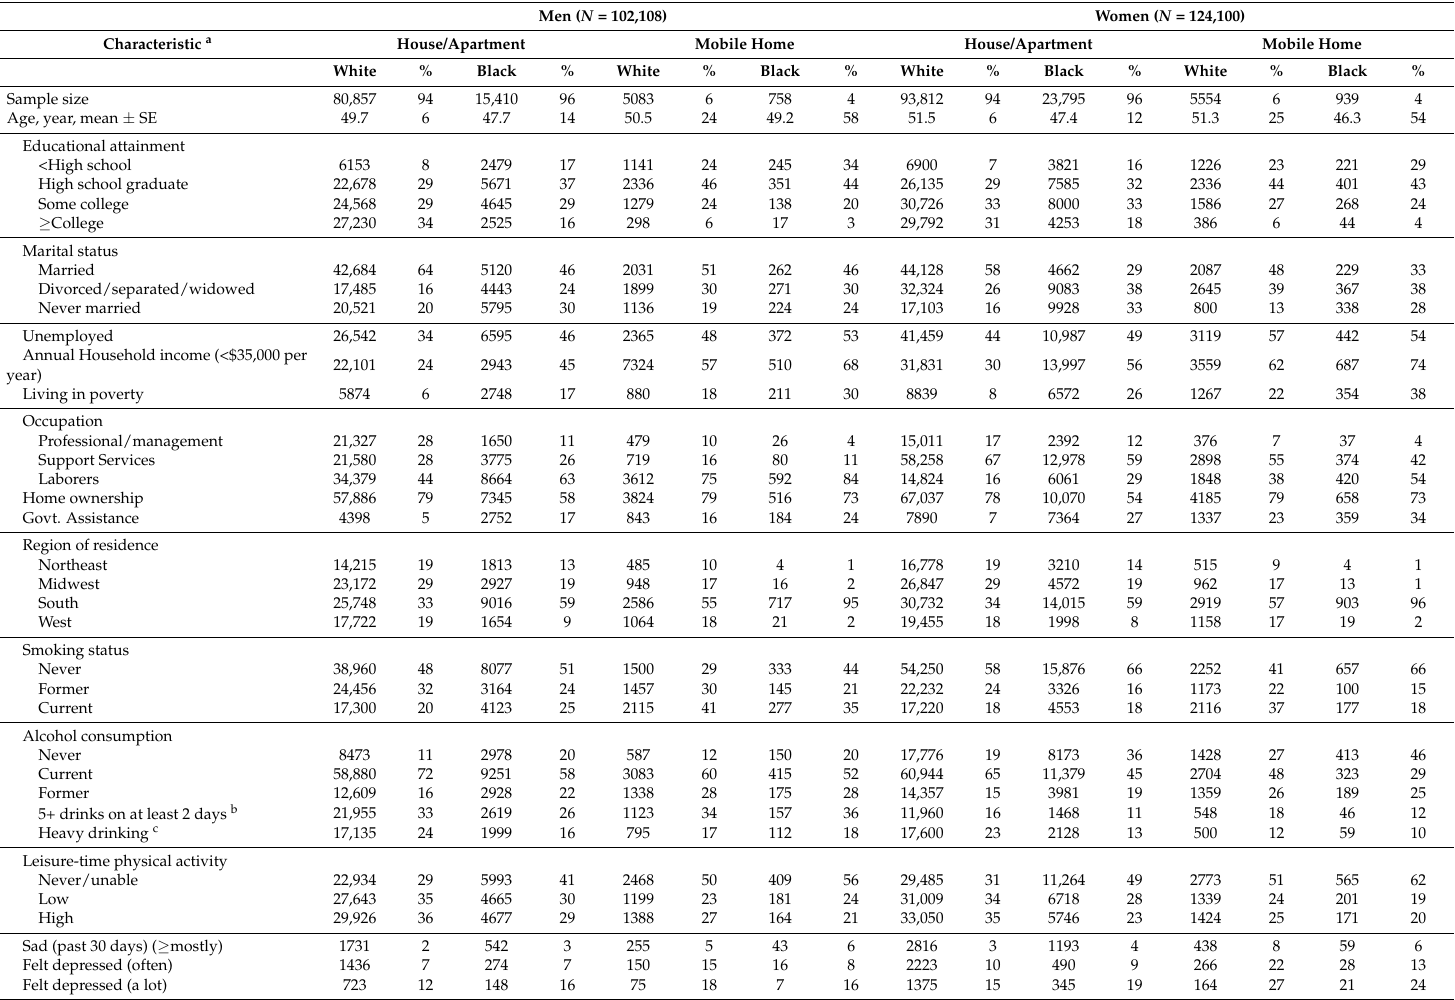
Table 1. Sociodemographic, Health Behavior, Clinical, and Healthcare Access/Utilization Characteristics among U.S. Adults by Housing Type Stratified by Gender, National Health Interview Survey, 2004–2015 ( N =